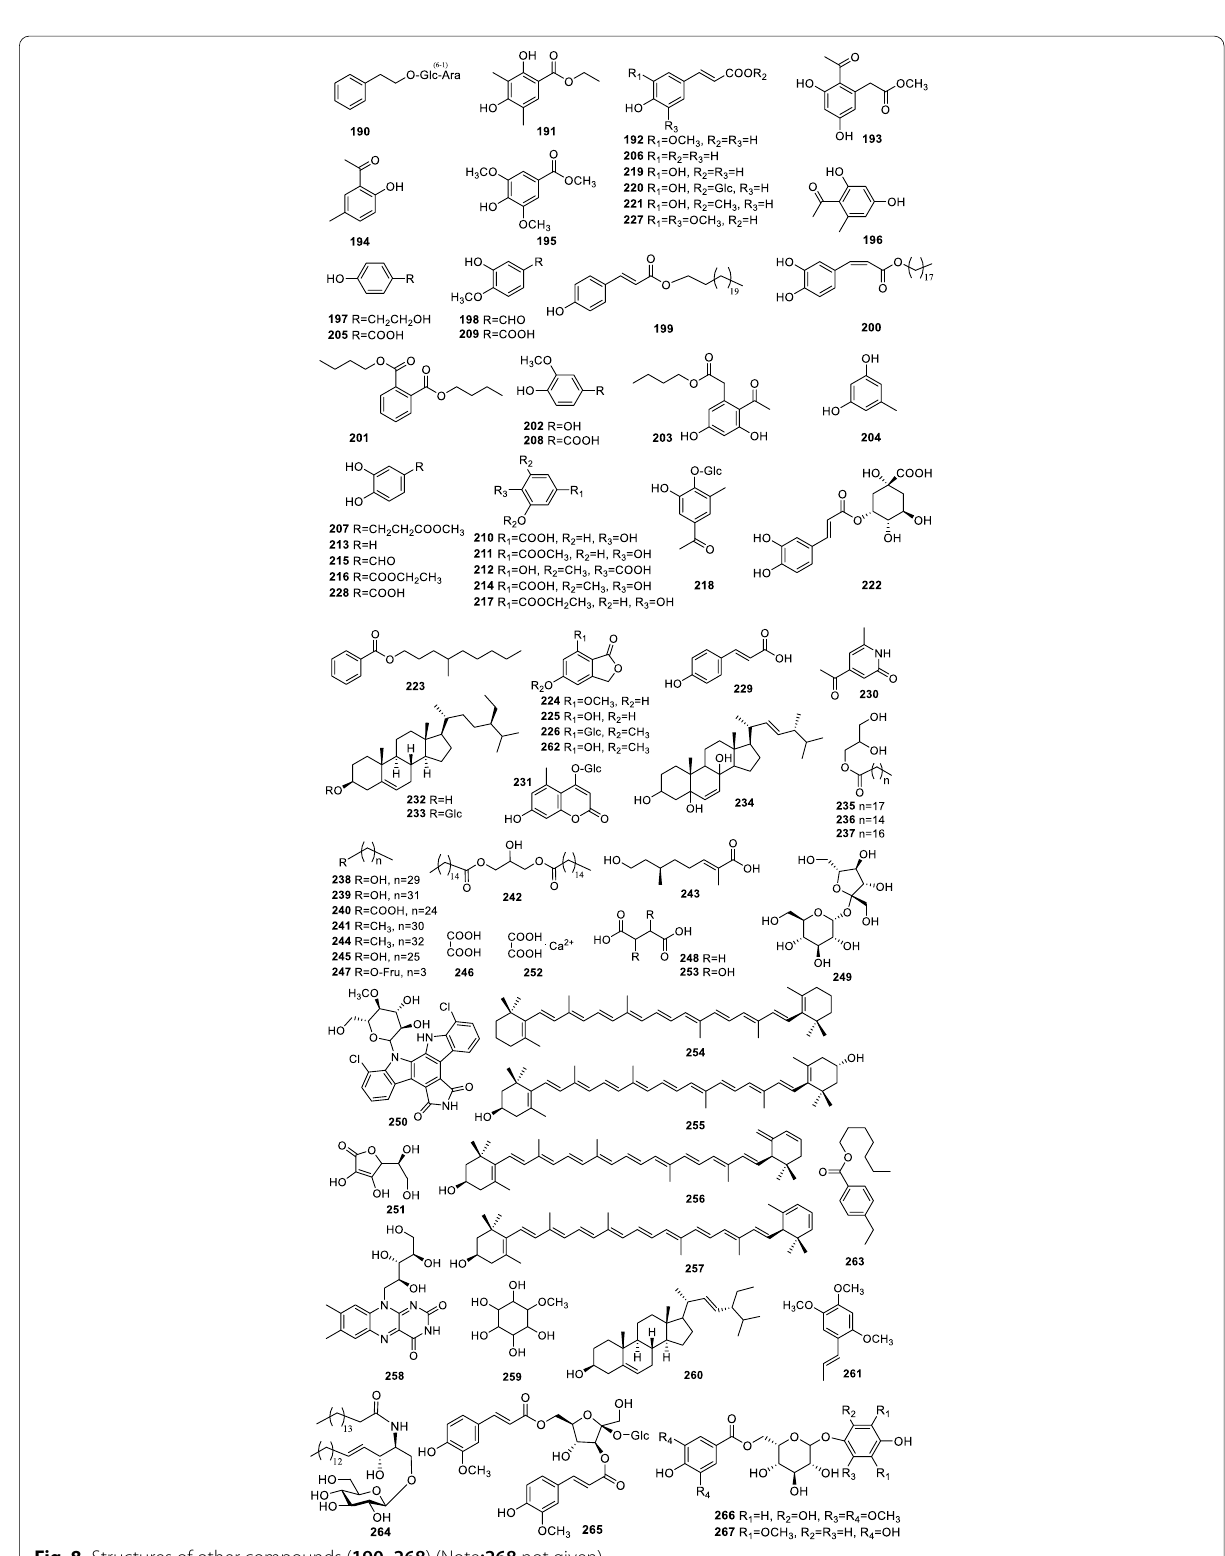
Fig. 8 Structures of other compounds ( 190–268 ) (Note :268 not